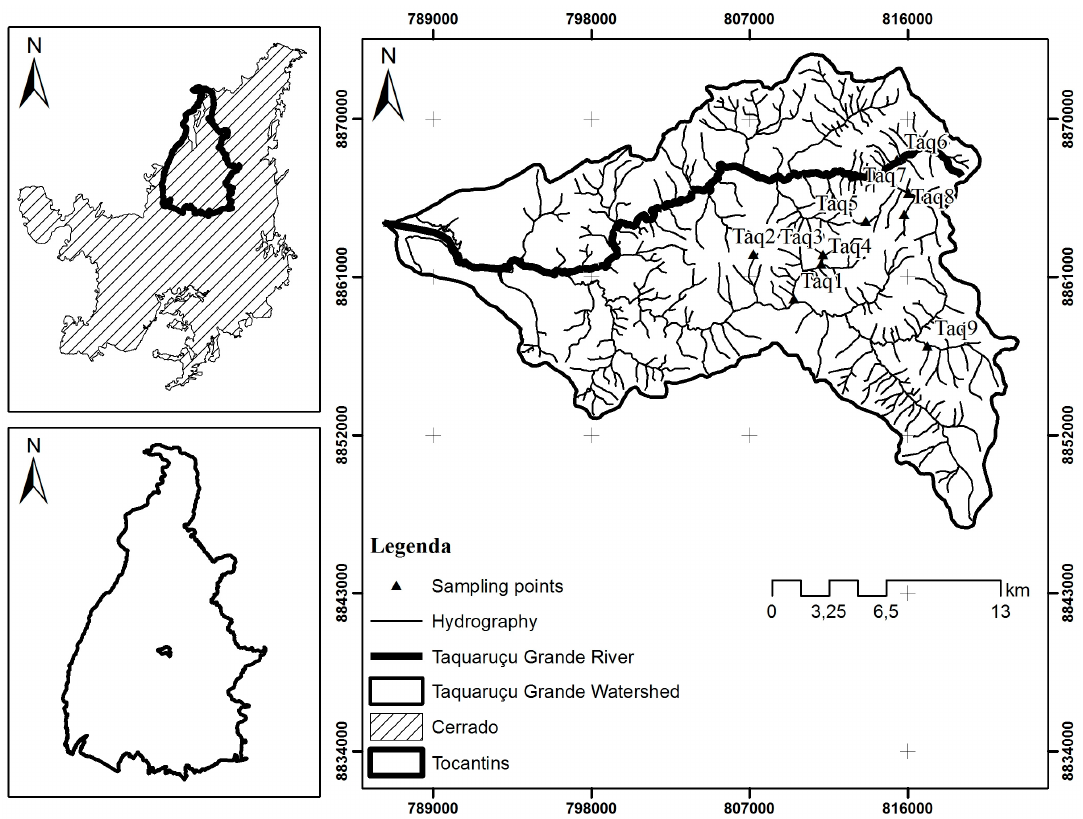
Figure 1. Map of the Taquaruçu Grande river basin showing the sampling points. Source: Bonatto, 2013.